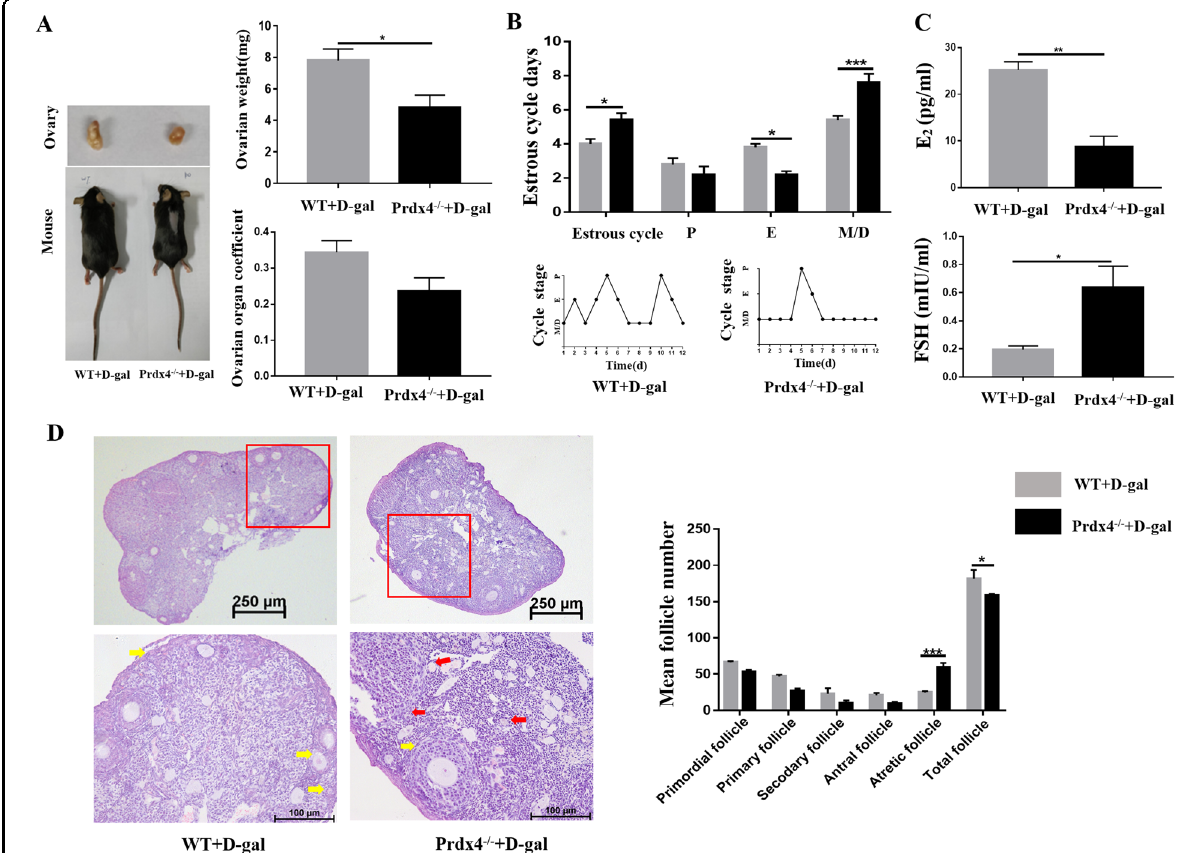
Fig. 2 Acceleration of reproductive ageing in Prdx4 − / − mice. WT and Prdx4 − / − mice were injected with D -gal (150mg/kg/d) for 42 consecutive days ( n = 5 mice per group). a Representative images of ovaries and mice from the two groups are shown. There was a signi fi cant difference in ovarian weight between the two groups and a substantial decrease in ovarian organ coef fi cient in the Prdx4 − / − group. b The mean durations of the oestrous cycle and number of days spent in pro-oestrus (P), oestrus (E), metoestrus (M), and dioestrus (D) were evaluated by vaginal cytology over the course of 12 consecutive days. The representative oestrous cyclicity in each treatment group is presented. c Serum E 2 and FSH levels during dioestrus were measured in the two groups. d Histology of ovarian sections from the two groups. The yellow arrows show the primordial, primary, or secondary follicles, and the red arrows indicate the developmentally arrested follicles with degenerating oocytes. Scale bars = 250 μ m at ×4 magni fi cation; scale bar = 100 μ m at ×20 magni fi cation. The number of follicles at different developmental stages is summarised. All data are shown as means ± SEMs, n = 5. Statistical signi fi cance: * P < 0.05, ** P < 0.01, *** P <